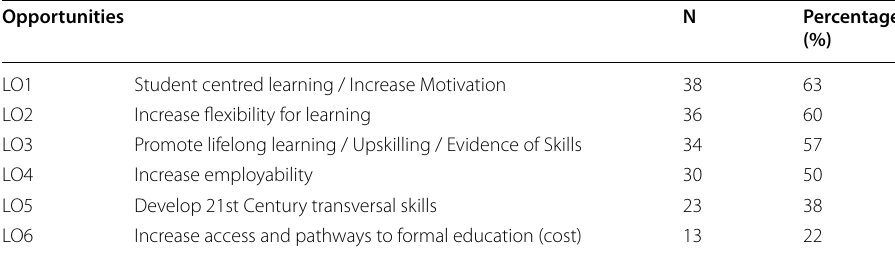
Table 2 Summary view of the critical challenges offered by micro-credentials for learners Challenges N Percentage LC1 Attainment of Knowledge